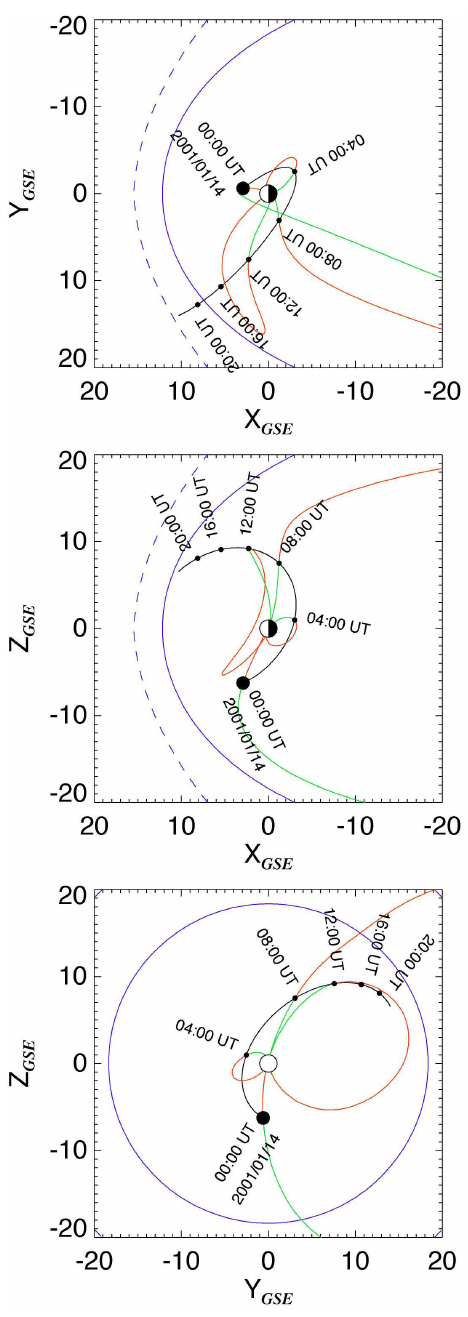
Fig. 1. Plot of a part of the Cluster orbit on 14 January 2001, in a model of the magnetosphere (Tsyganenko-96, see text for cho- sen input parameters) projected onto the GSE XY -, XZ - and YZ - planes (i.e. from top to bottom seen from the top, east and front of the magnetosphere). The UT times for the momentary location of Cluster are indicated every 4h, starting in the southern hemisphere, through perigee and towards the final exit from the magnetopause in the northern hemisphere. The full blue line represents the model magnetopause, the broken blue line in the top two panels the model bow-shock, and the green and red lines are field lines connecting Cluster to the northern and southern hemisphere,